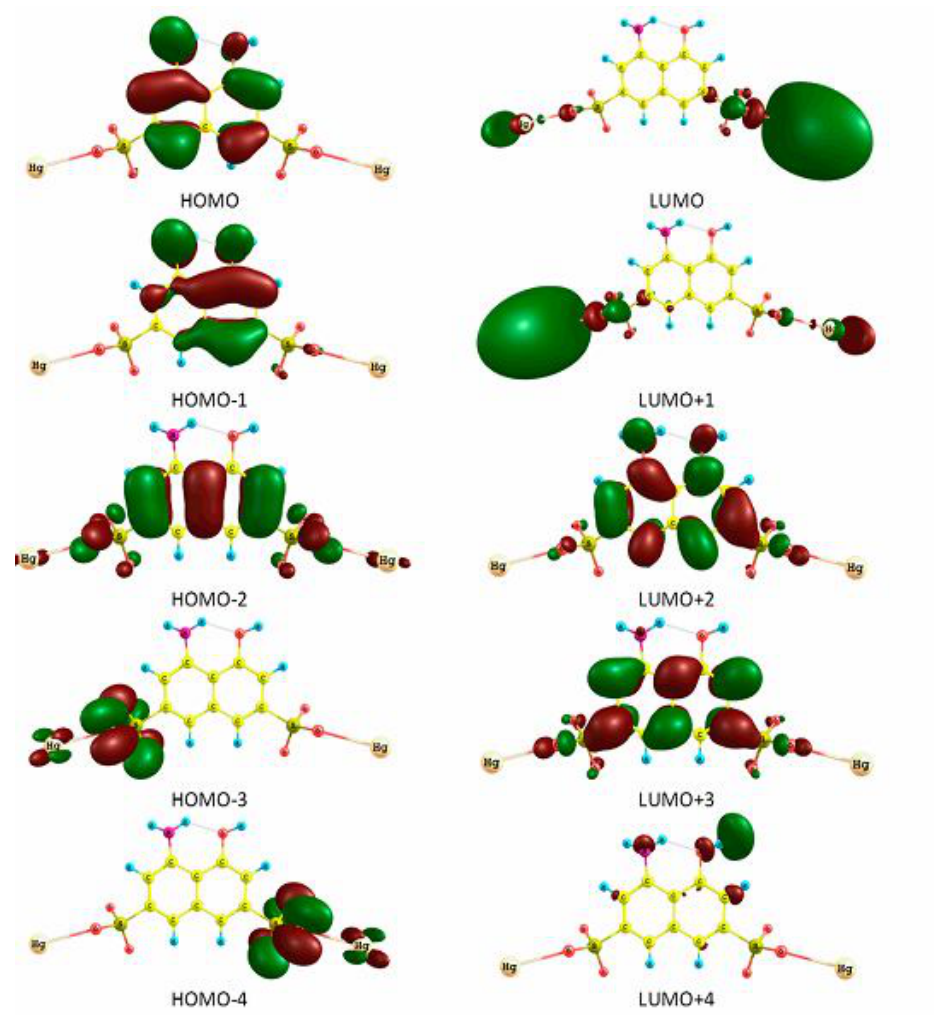
Fig. 18. Frontier molecular orbitals of [H-acid]Hg 2+ calculated in aqueous solution at PBE0/6-31++G ** PCM level of theory